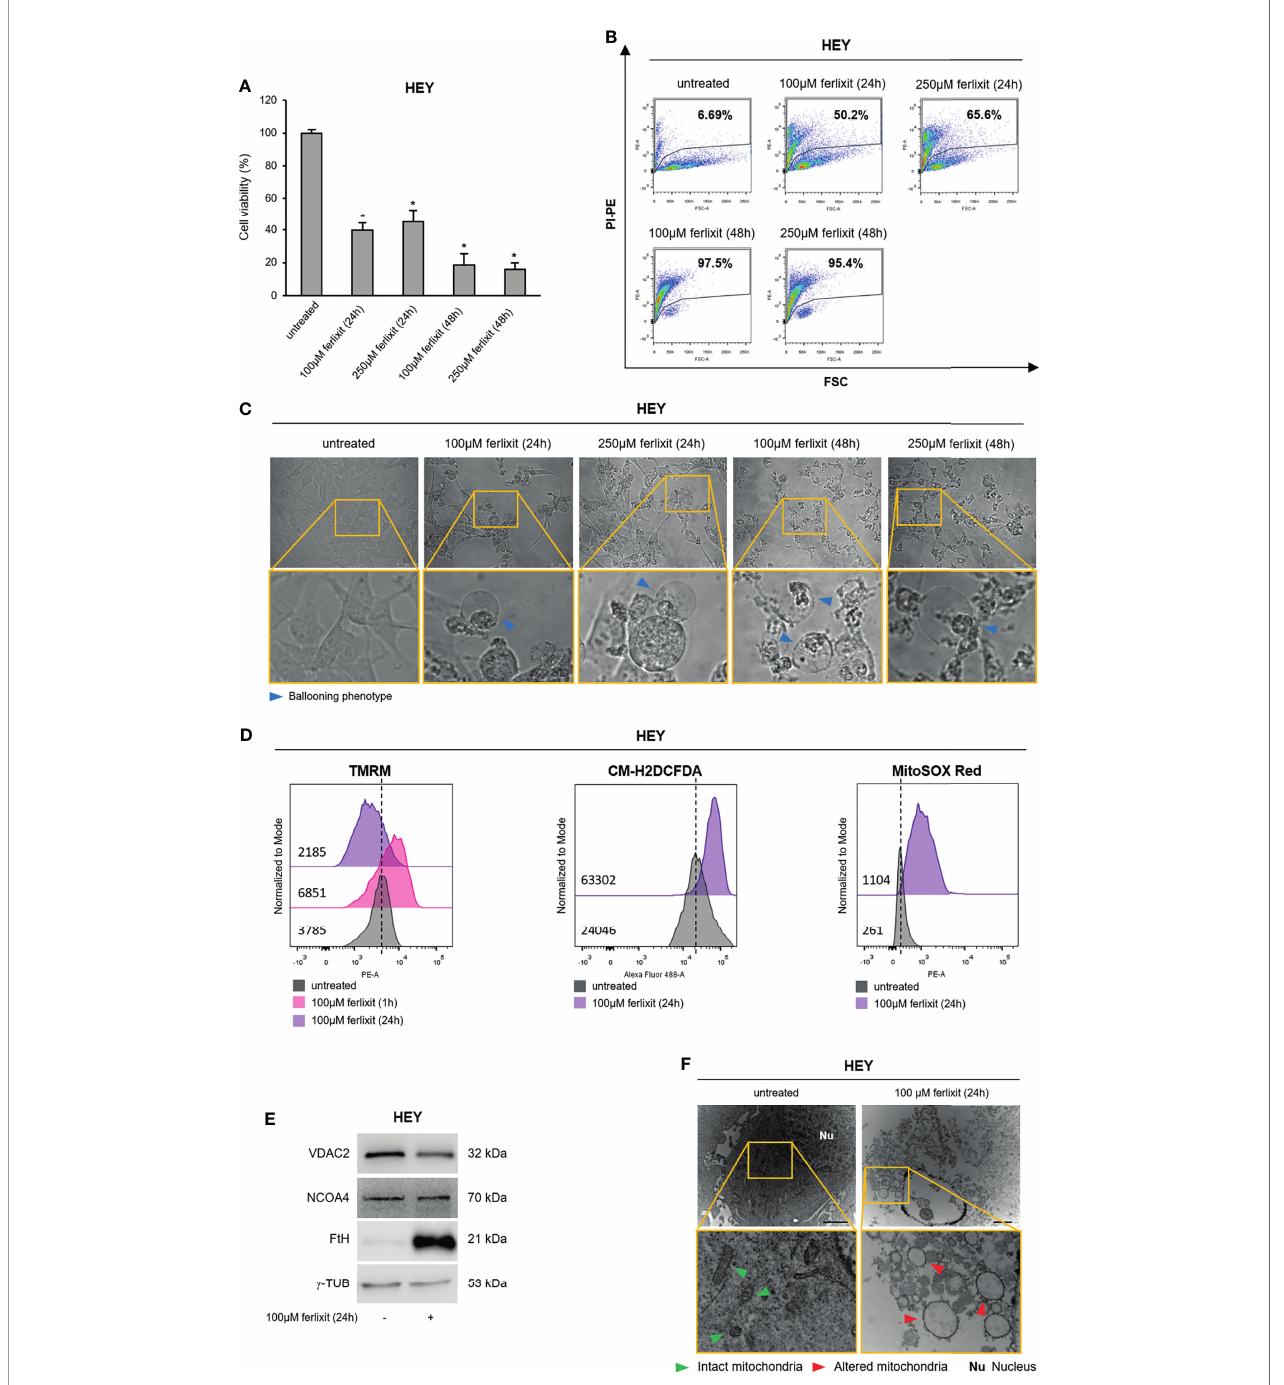
FIGURE 6 | Ferlixit admnistration alone induces ferroptosis in HEY cells. HEY cells were treated with different concentrations (100 and 250 µM) of ferlixit for 24 and 48 h. Cell viability and mortality were measured using the MTT assay (A) and PI fl ow cytometry assay (B) , respectively. Results are shown as means±SD of three independent experiments. * p -value <0.05, untreated vs treatment. (C) Optical microscopy images showing the presence or absence of the ballooning phenotype in HEY cells upon treatment with different concentration of ferlixit. (D) Analysis of mitochondrial membrane potential, cytosolic and mitochondrial ROS production by TMRM, CM-H2DCFDA and MitoSOX Red fl ow cytometry assays in HEY cells untreated or treated with 100 µM ferlixit for 24 h. (E) Western Blot of VDAC2, NCOA4 and FtH in HEY cells upon administration of 100 µM ferlixit for 24 h. g -TUB was used as a normalization control for protein quanti fi cation. (F) Mitochondrial ultrastructural images detected by TEM in HEY cells treated with 100 µM ferlixit for 24 h. Green arrows, intact mitochondria; red arrows, altered mitochondria; Nu, nucleus. All data are representative of three independent